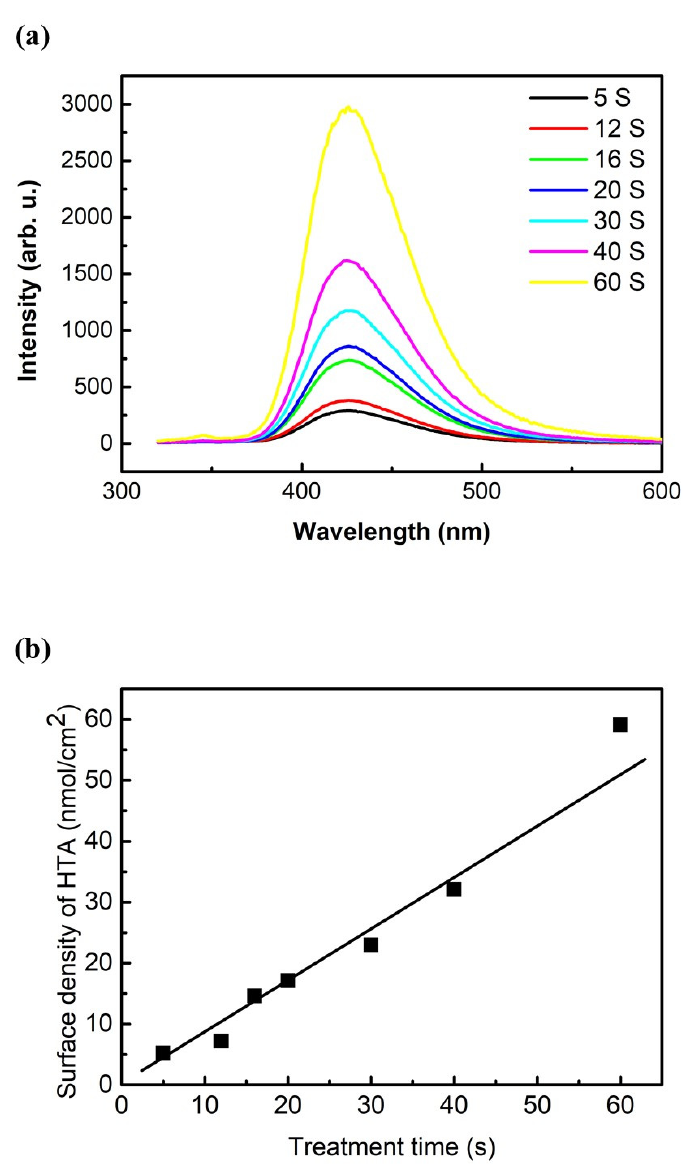
Figure 5. Measurements of RONS in the aqueous solution based on terephthalic acid (TA). Tereph- thalic acid (TA) was oxidized into 2-hydroxyterephthalic acid (HTA) by RONS in aqueous solution. When the TA/HTA solution was irradiated by UV light ( λ = 310 nm), HTA molecules emitted light at λ = 425 nm. ( a ) The fluorescence spectra of the HTA solutions obtained by changing the plasma treatment time. The initial concentrations of TA and NaOH in the aqueous solution were 4 nM and 10 nM, respectively. ( b ) The surface density of HTA obtained in the treated solutions as a function of treatment time. To quantify the concentration of TA molecules oxidized into HTA, a calibration curve was obtained by using the standard HTA solution.